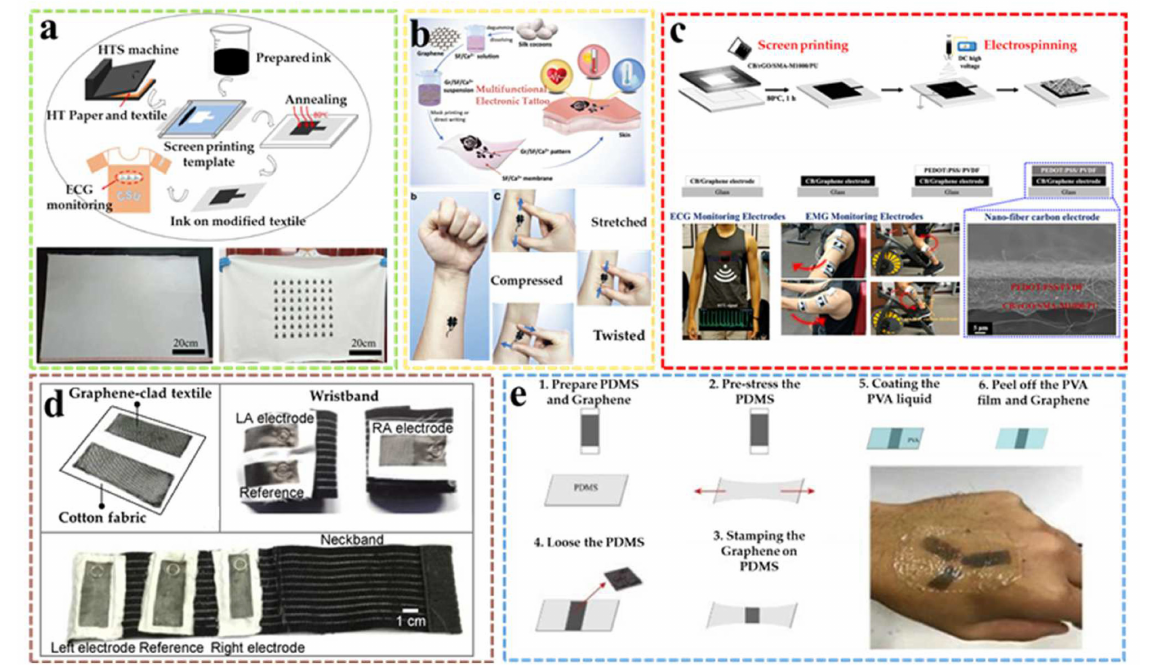
Figure 2. ( a ) The fabrication process ( left ) and photos ( right ) of the cotton-textiles-based graphene ECG electrode. Reprinted with permission from Ref. [45]. Copyright 2020, IOPscience. ( b ) The fabri- cation process of the Gr/SF/Ca 2+ tattoo electrode and its stable adhesion on human skin. Reprinted with permission from Ref. [47]. Copyright 2020, Wiley. ( c ) The preparation process of the nanofiber- based graphene ECG electrodes ( above ), its applications in ECG and EMG monitoring ( lower left ), and its SEM images ( lower right ). Reprinted with permission from Ref. [51]. Copyright 2021, Amer- ican Chemical Society. ( d ) The graphene–nylon-based textile electrodes and their integration in a garment. Reprinted with permission from Ref. [53]. Copyright 2017, MDPI. ( e ) Preparation pro- cesses of the PVA/graphene biodegradable electrode. Reprinted with permission from Ref. [56]. Copyright 2020, International Journal of Engineering Research and